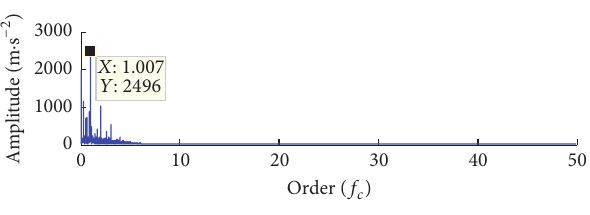
Figure 9: The entire order envelope demodulation spectrum of the simulated